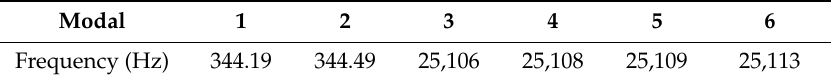
Table 2. E ff ective modes of the novel biaxial bionic hair flow